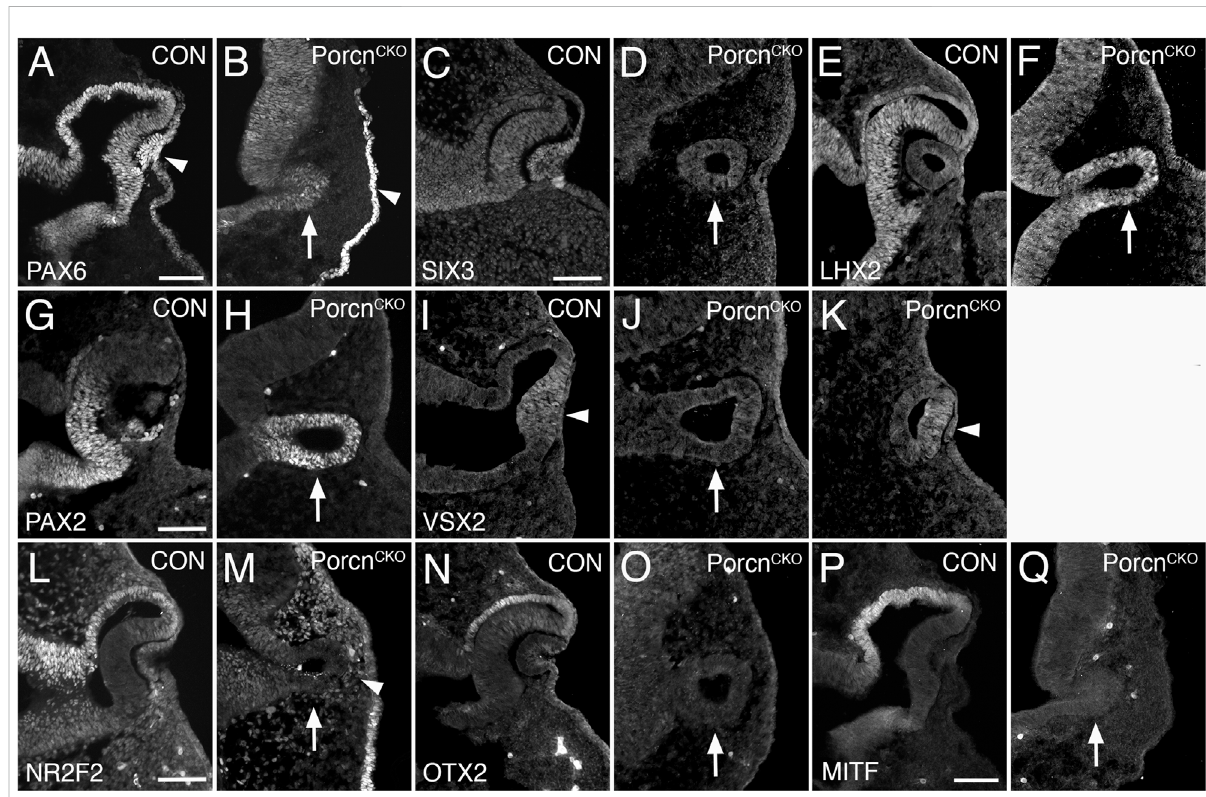
FIGURE 3 Porcn mutantembryosdisplaydefectiveregionalizationatE10.5.Coronalviewofcontrolembryos (A,C,E,G,I,L,N,P) and Porcn CKO embryosthat weretreatedwithtamoxifenatE7.4 (B,D,F,H,J,K,M,O,Q) . (A) Duringnormaleyedevelopment,PAX6isexpressedinoculartissuesandintheoverlying surface ectoderm (arrowhead). (B) In the mutant OV, PAX6 expression is expressed (arrow) and is present in the surface ectoderm (arrowhead). (C and D) SIX3 expression is not altered in the OV and surface ectoderm of Porcn CKO (D; arrow). (E and F) In control (E) and in Porcn CKO (F; arrow) LHX2isexpressedthroughouttheOCandOV,respectively. (G) IncontrolOC,PAX2isrestrictedtotheventralOC. (H) In Porcn CKO ,PAX2expressionis maintained throughout the OV (arrow). (I) In controls, the distal OC is tightly attached to the overlying lens ectoderm and expresses VSX2 (arrowhead). (J) In Porcn CKO with loss of close contact, VSX2 is not detectable (arrow). (K) When distal OV and lens ectoderm are closely associated, some cells in the distal OV in Porcn CKO can express VSX2 (arrowhead). (L) NR2F2 expression shown in control embryos. (M) In the OV of Porcn CKO , NR2F2expressionismissing(arrow).NRF2expressingPOMcellsareabnormallypresentbetweendistalOVandsurfaceectoderm(arrowhead). (N,O) OTX2 is normally robustly expressed in the presumptive RPE of the OC but is absent in the mutant OV (O; arrow). (P) MITF is an early differentiation marker restricted to the presumptive RPE. (Q) In the OV of Porcn CKO , MITF expression is not detectable (arrow). Scale bars A, C, G, L, P: 0.1